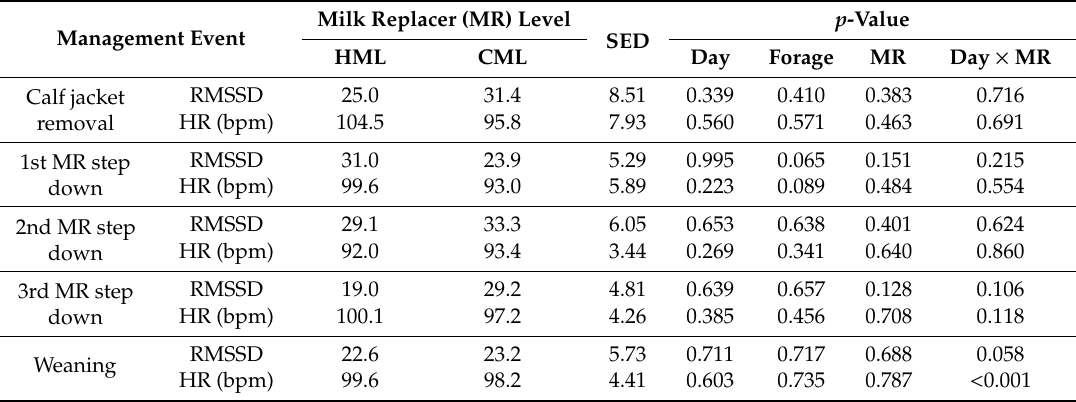
e ff ect of forage treatment on HR or RMSSD throughout the experimental period (Table 8). Table 8. Heart rate (bpm) and heart rate variability (RMSSD) of calves managed under di ff erent nutritional regimes in the first ten weeks of